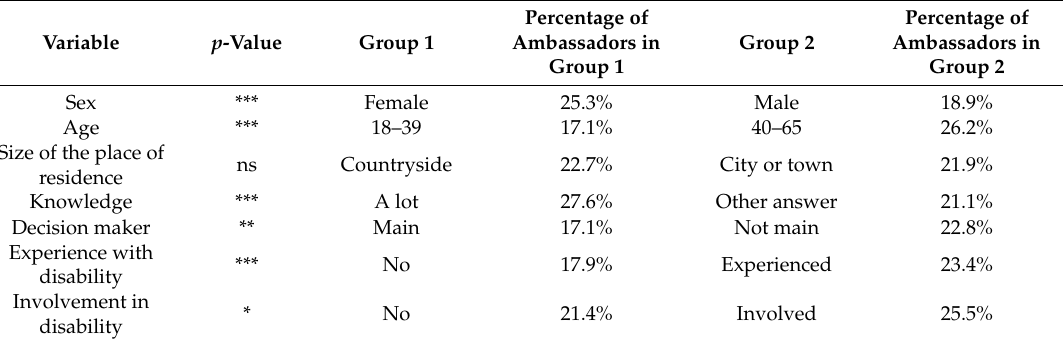
Table 6. Significance of dependence between Ambassador feature and independent variables ( χ 2